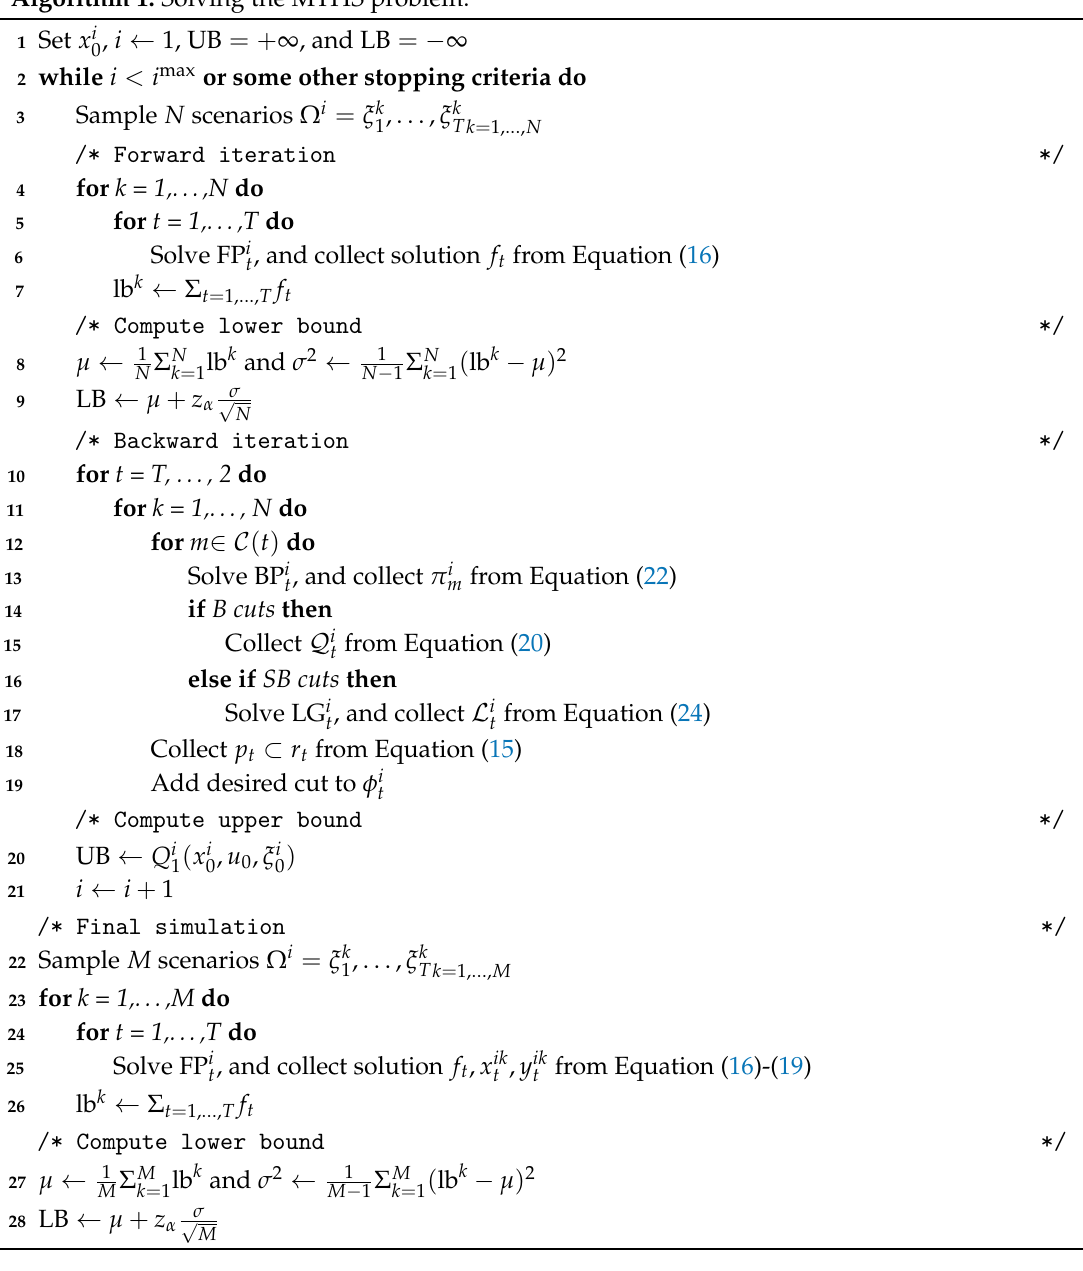
Algorithm 1: Solving the MTHS